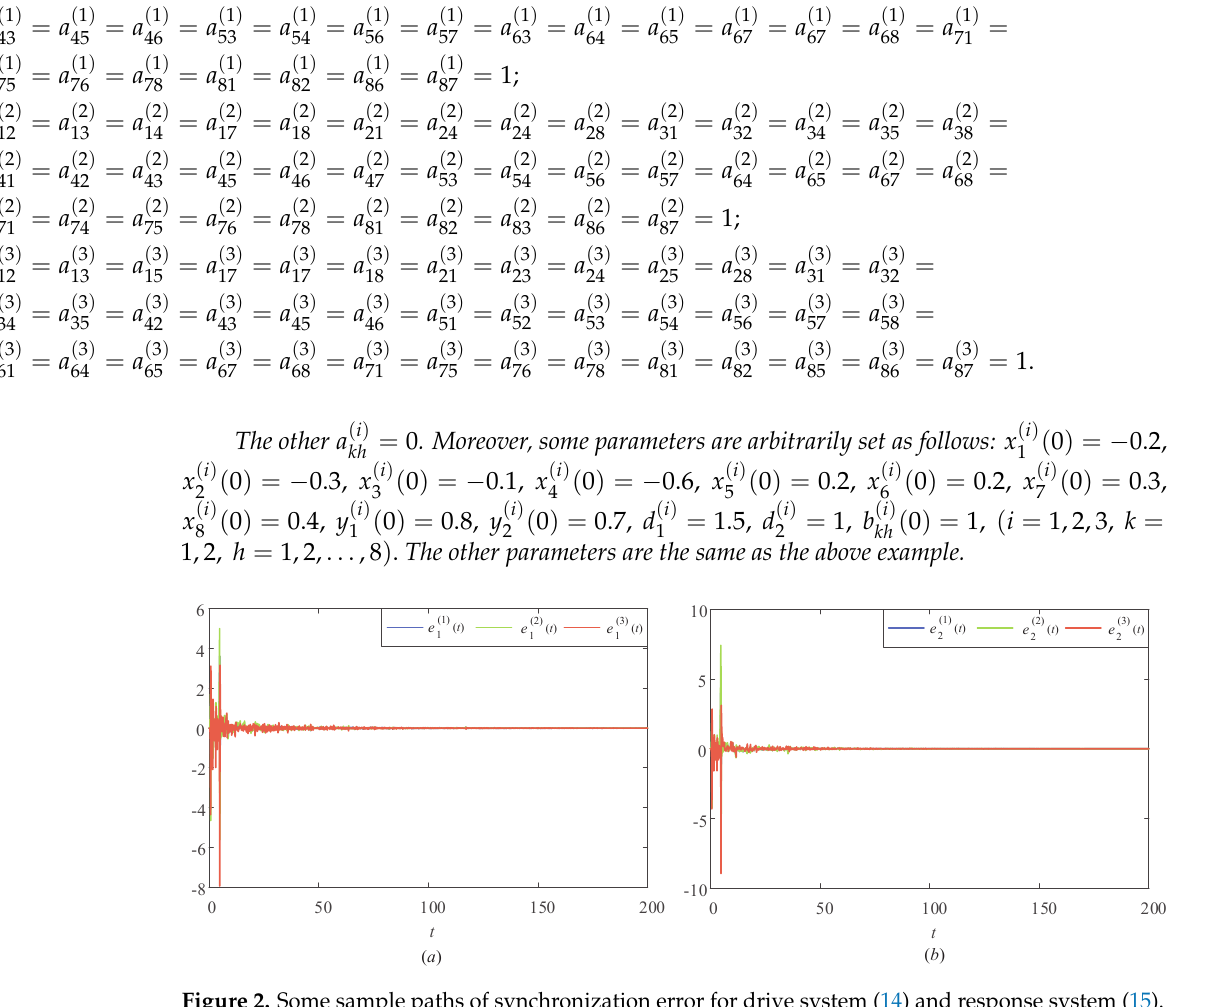
Figure 2. Some sample paths of synchronization error for drive system (14) and response system